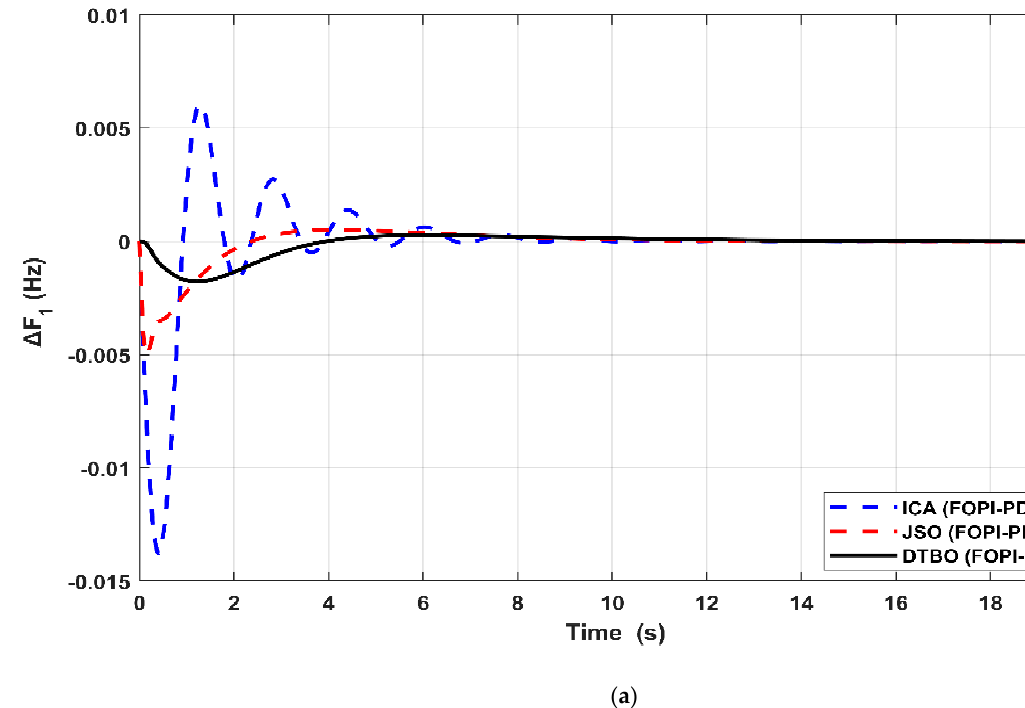
algorithm outperforms JSO, ICA, hDE-PS [42], hTLBO with PS [10], and FPA [25] techniques.